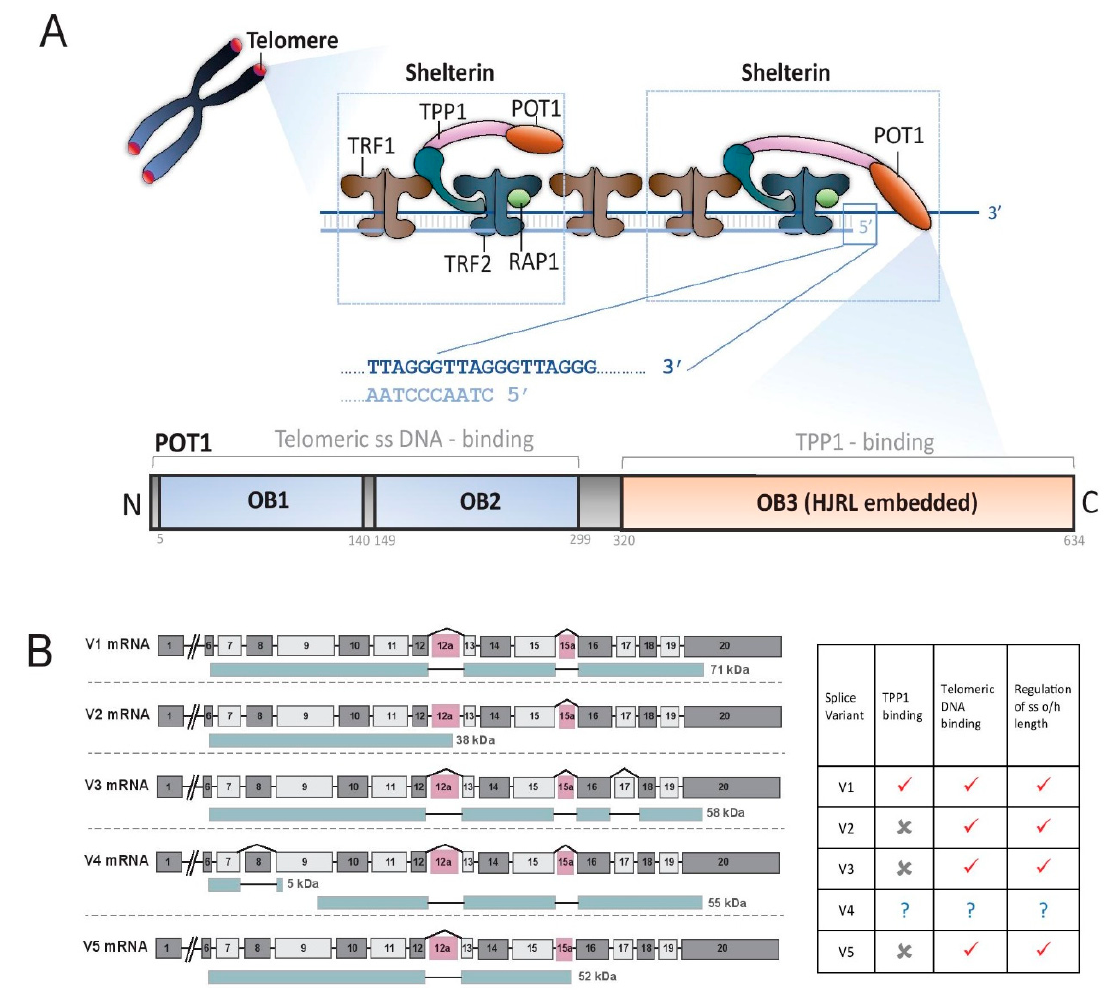
Figure 1. Shelterin complex and Protection of Telomeres 1 (POT1) protein. ( A ) Telomeres are composed of tandem repetitive TTAGGG sequences that are predominantly double-stranded (ds) but terminate in a single stranded (ss) 3 ′ -overhang of the G-rich strand [6,36] . Telomeres are shielded with the shelterin complex, consisting of the TRF1, TRF2, RAP1, TIN2, TPP1 and POT1 proteins. POT1 binds to the TPP1 protein and to telomeric ss DNA through its C- and N-termini, respectively, and controls the sequence at the ds/ss junction. The human POT1 protein contains three oligonucleotide/oligosaccharide-binding (OB) fold domains, namely OB1-3, and OB3 has an embedded Holliday junction resolvase-like (HJRL) domain. ( B ) POT1 splice variants and their functions